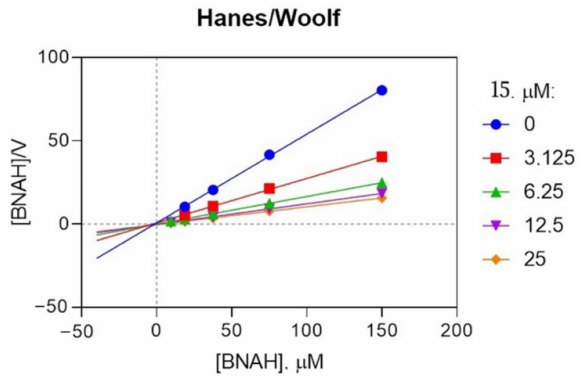
Figure 4. Kinetic evaluation of NQO2 inhibition by compound 15 .